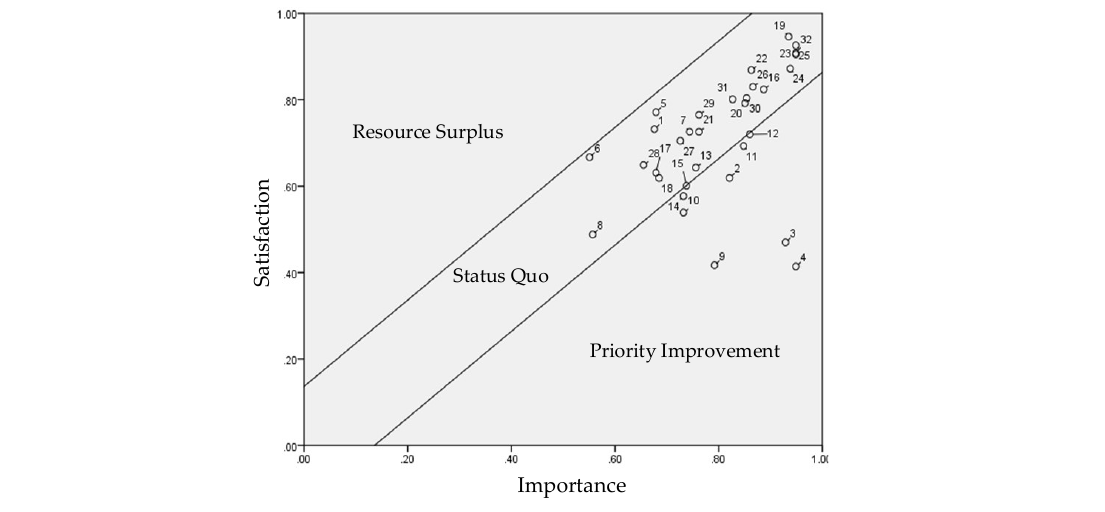
Figure 5. Performance Evaluation Matrix (PEM) of the Male Respondents. We used Equations (3) and (4) to calculate the population mean and error values of the 32 importance–satisfaction items. In the matrix composed of importance and satisfaction indicators, the population means and error values for the male respondents were 4.009 and 0.136, respectively, and those for the female respondents were 4.009 and 0135,